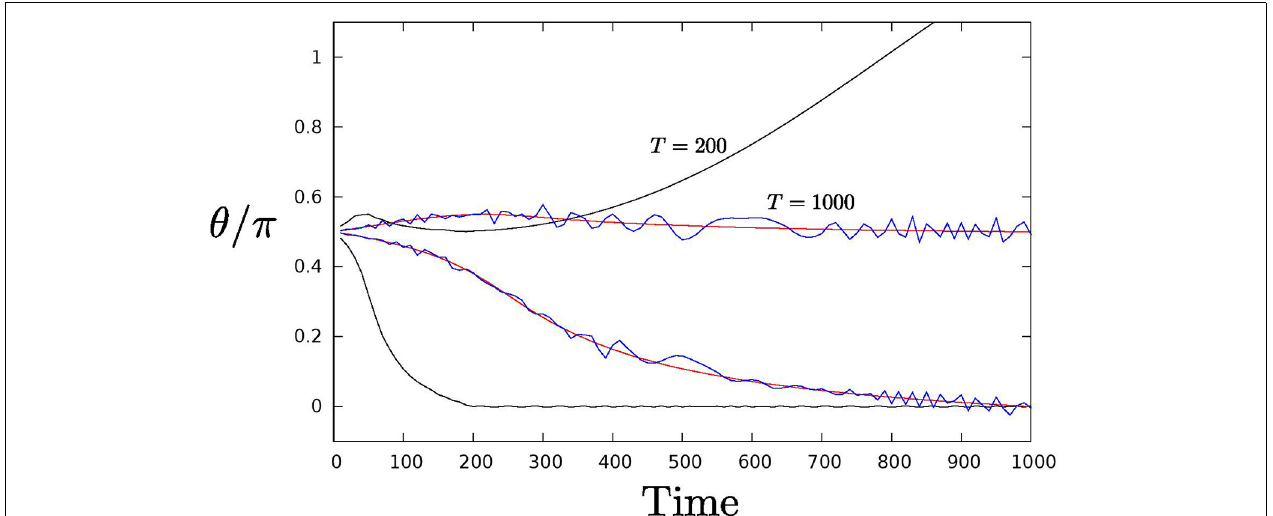
FIGURE 2 | Results for eight spin model. Three runs are shown. In each case the angle θ of a representative core spin and ancilla spin are shown as a function of time. The core spins are all driven to θ = 0 while the ancilla spins are ideally driven to θ = (cid:4)/ 2. (1) The red lines show a case with no noise and with adiabatic drag time T = 1000. (2) The blue lines have added noise again with T = 1000. The noise was